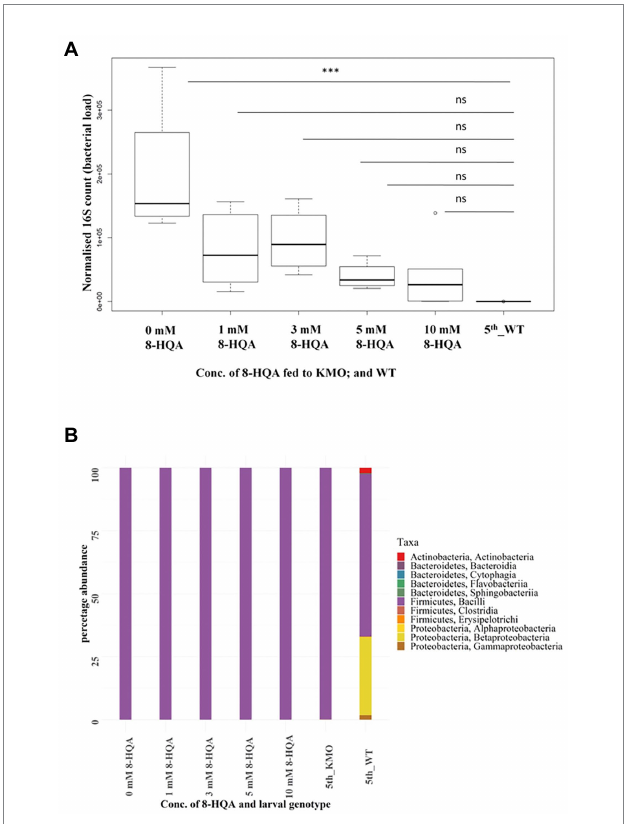
FIGURE 5 Results of feeding 8-HQA to KMO knockout larvae. (A) Normalized 16S copy numbers of the same groups of larvae, a measure of the bacterial abundance in each condition: 5th instar larvae-KMO-ko fed with 0, 1, 3, 5, 10 mm 8-HQA, and WT. The bacterial numbers of KMO-ko approach that of WT upon administration of the compound (ANOVA, p < 0.05, Tukey’s test between 0 mm 8-HQA and WT < 0.05). (B) Bacterial composition of KMO-ko larvae fed with the same increasing concentration of 8-HQA, KMO-ko control, and WT. The taxa distribution of KMO-ko do not resemble that of WTs, and Bacilli is the most abundant class in KMO-ko even after administration of